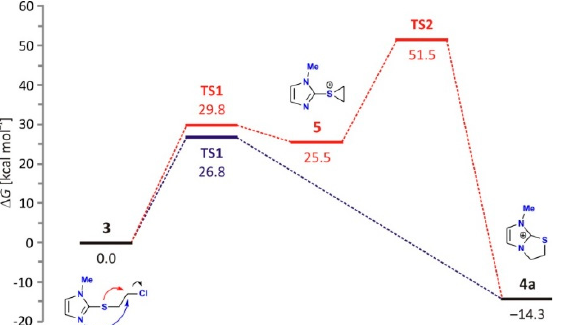
Figure 11. Reaction pathways for the 3 → 4a conversion involving (i) a two-step reaction including a thiiranium ion 5 intermediate (in red), and (ii) a direct single-step process without any intermediated (in blue). Relative energies of the stationary points are obtained at the (SMD)/M06–2X/6–31+G(d) model.